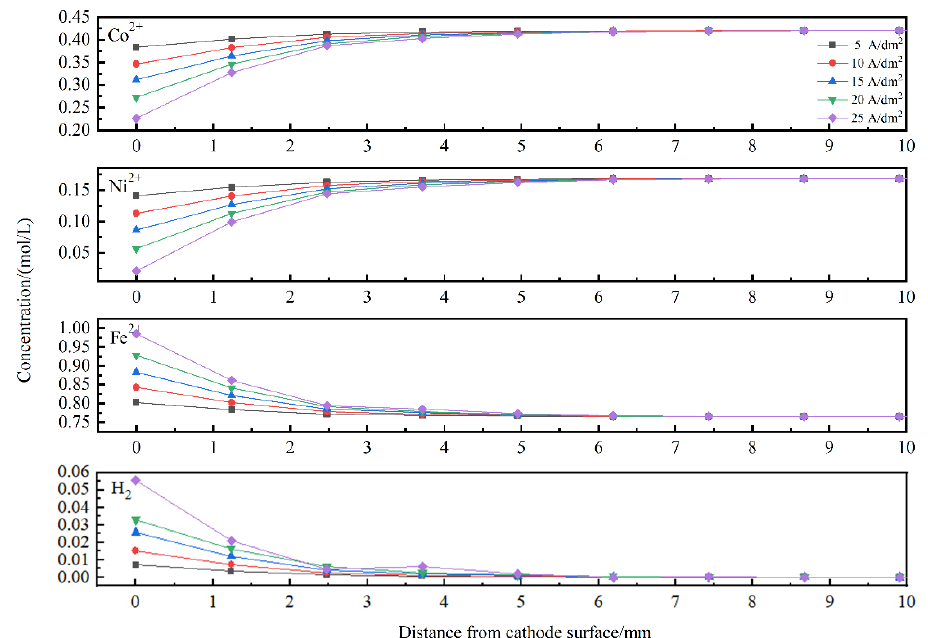
Figure 10. Concentration profiles near cathode surface ( t = 60 min) .